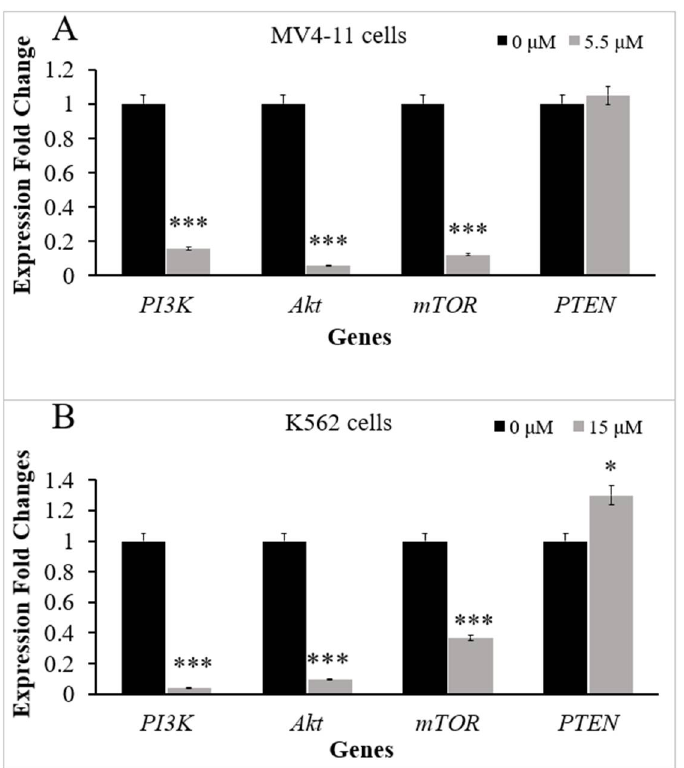
Figure 2. Effect of TQ on PI3K/Akt/mTOR signaling expression in MV4-11 and K562 cells. RT-qPCR analyses were performed. The graph demonstrates the downregulation of PI3K, Akt, and mTOR genes and upregulation of PTEN in ( A ) MV4-11 cells and ( B ) K562 cells after treatment with TQ. The data represent three separate experiments and are presented as the median and interquartile range (error bars). Wilcoxon signed ranks test was conducted. Where * p < 0.05 and *** p < 0.001 are significant versus untreated control cells.